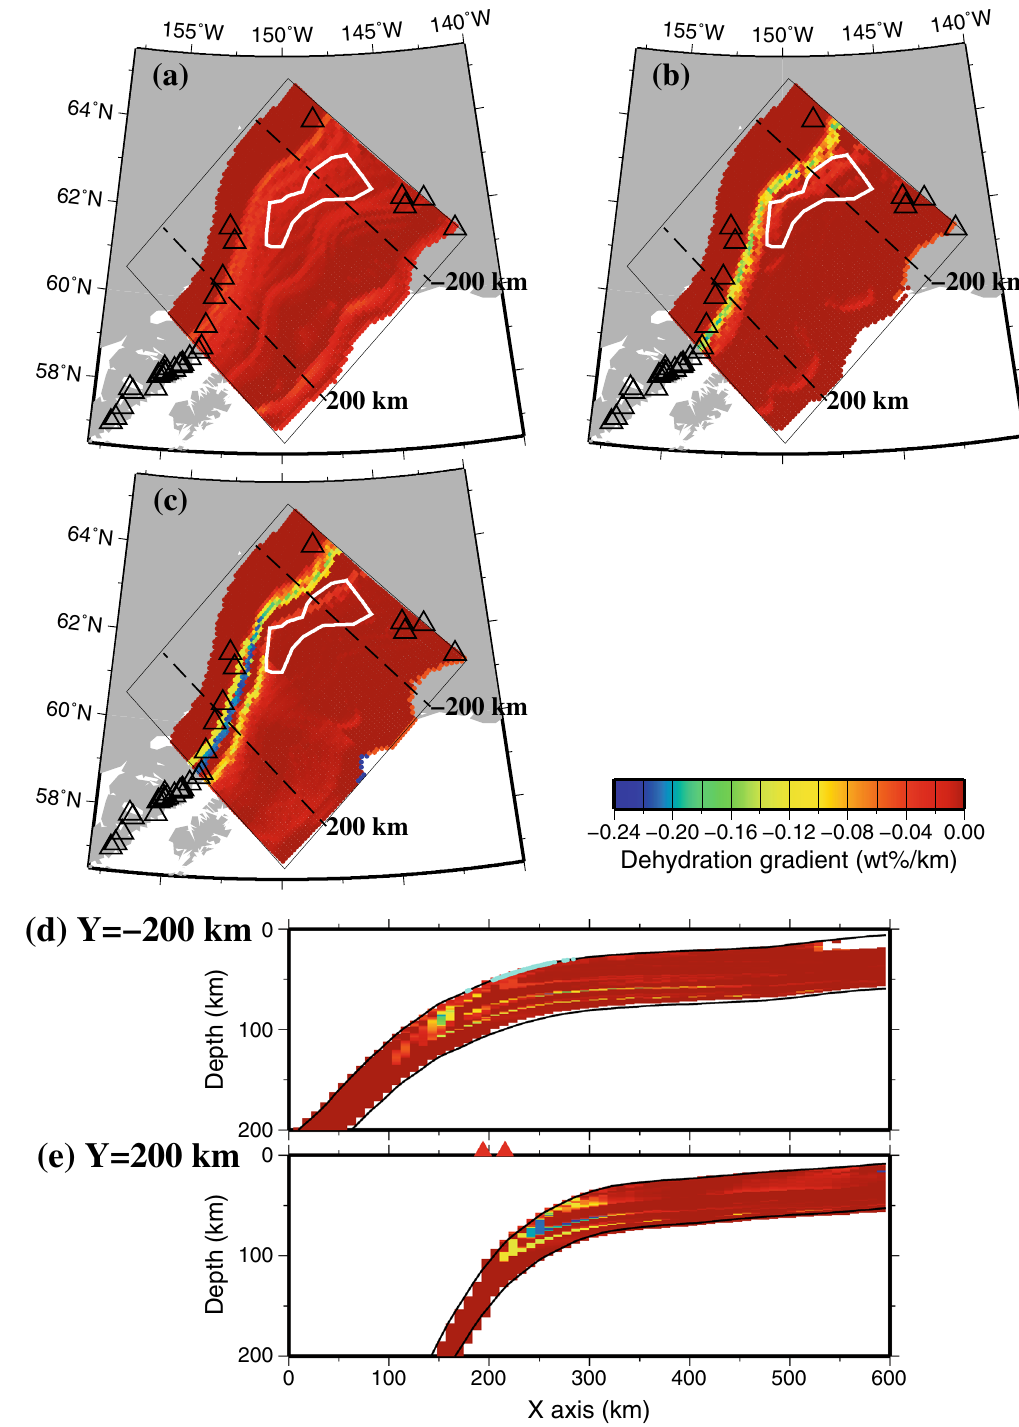
Figure 4. Dehydration gradient distribution in the slab at present (0 Ma). The thin black box represents the model region. The dehydration gradient distribution is plotted only in the region where the depth of the slab surface is shallower than the bottom of the model (200 km) and where the temperature is higher than 200 °C, for which values of phase diagram data exist. The white line indicates the area where tectonic tremors occur, as shown in Fig. 1, and the black dashed line indicates the location of profile Y = − 200 km and Y = 200 km. The open triangles represent volcanoes. ( a ) The slab surface (0 km). ( b ) 6 km depth from the slab surface. ( c ) 10 km depth from the slab surface. ( d )The vertical cross section along profile Y = − 200 km. The dehydration gradient distribution is plotted only in the region where the temperature is higher than 200 °C, for which values of phase diagram data exist. The two solid black lines represent the top and bottom surfaces of the slab. The light blue solid circles represent the hypocentres of tectonic tremors within a one-sided width of 1 km. ( e ) The vertical cross section along profile Y = 200 km. The red solid triangles represent volcanoes within a one-sided width of 50 km. The others are the same as ( d ). The map was created by using the Generic Mapping Tools (GMT) 25 (version: GMT 4.5.7, URL link: https:// www. gener ic- mappi ng- tools. org/ downl